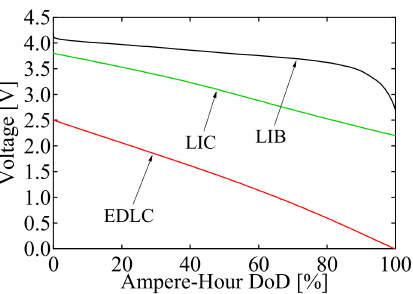
Figure 1. Voltage variations of lithium-ion battery (LIB), lithium-ion capacitor (LIC), and electric double-layer capacitor (EDLC) cells as a function of ampere-hour DoD.